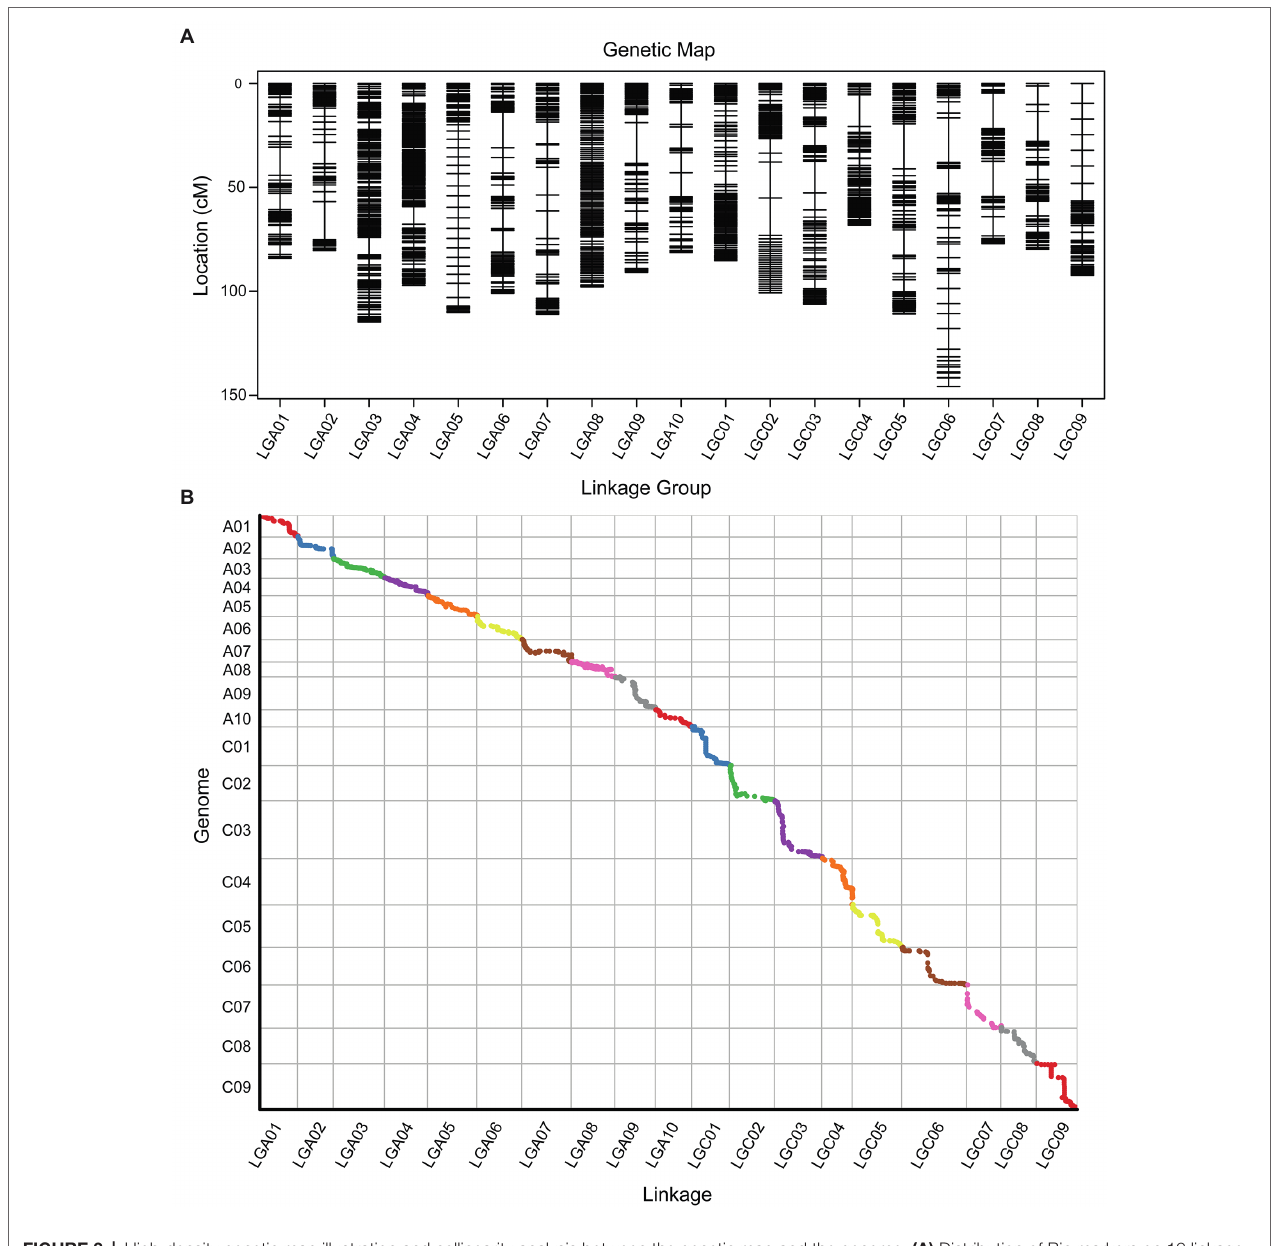
FIGURE 3 | High-density genetic map illustration and collinearity analysis between the genetic map and the genome. (A) Distribution of Bin markers on 19 linkage groups. Horizontal black lines on each linkage group represent mapped Bin markers. Vertical lines of each linkage group represent the total genetic distance (cM) of the linkage group. The linkage group ID is shown on the x -axis, and the genetic distance is shown on the y -axis. (B) The x -axis is the genetic distance of each linkage group. The y -axis is the physical distance of each chromosome, with the collinearity of genomic markers and genetic maps represented in scatter. Different colors represent different chromosomes or linkage